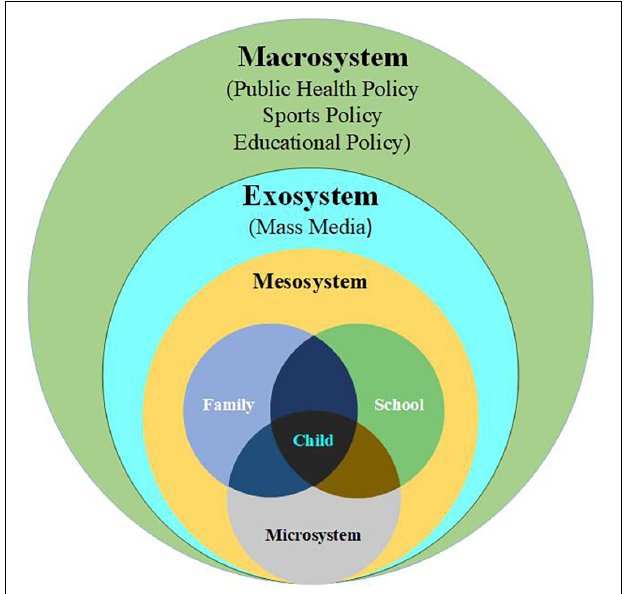
FIGURE 1 | Bronfenbrenner’s ecological model. Image reproduced with minor modifications from Bennett and Grimley (2001), with permission from Elsevier (License number